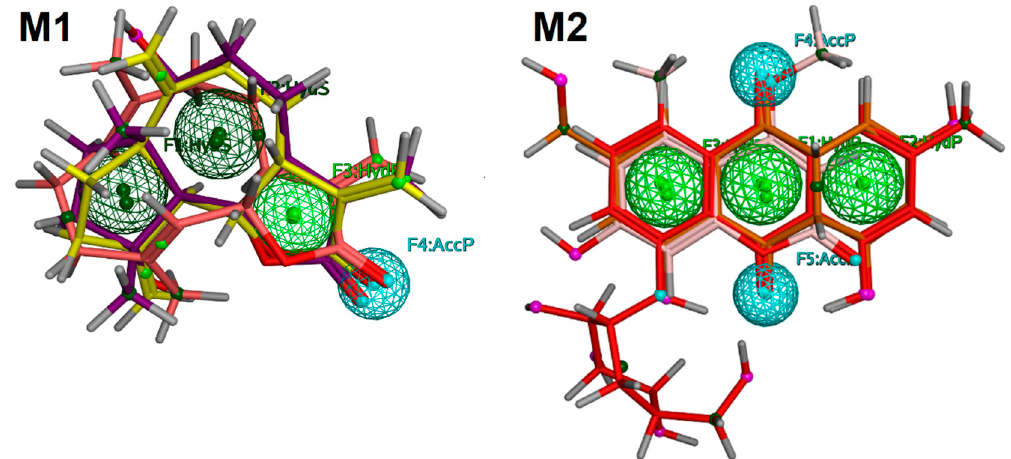
Figure 4. The depiction of pharmacophore models ( M1 and M2 ). The hydrophobic (Hyd) features are shown in green spheres, hydrogen bond acceptor (AccP) features are displayed in cyan spheres. The compounds (shown in stick model) are aligned on their respective pharmacophore models.